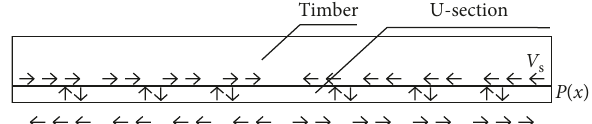
Figure 5: The mechanics model of bond-slip behavior between interface of “U”-shaped steel and